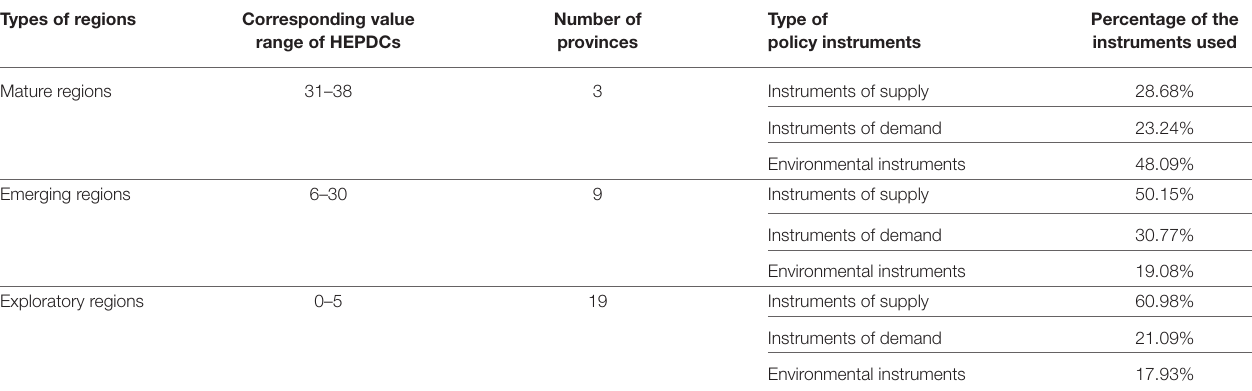
TABLE 2 | The usage of policy instruments in different regions.